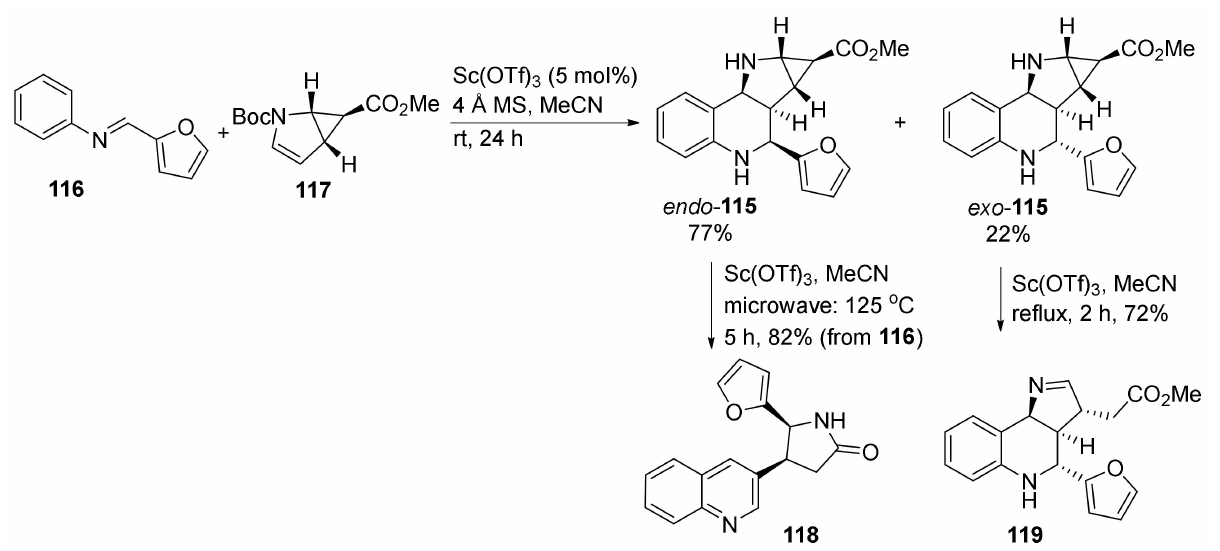
Scheme 18. Assembly of the pyrroloquinoline scaffold by Roy and